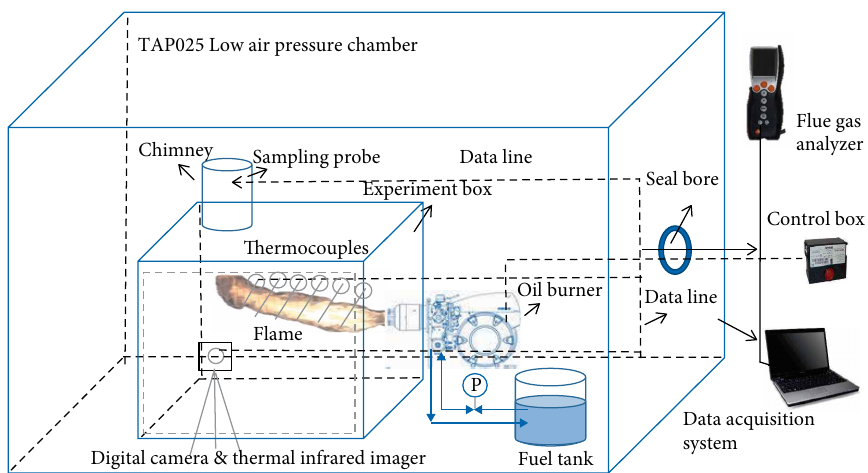
Figure 1: Schematic diagram of the experimental device.